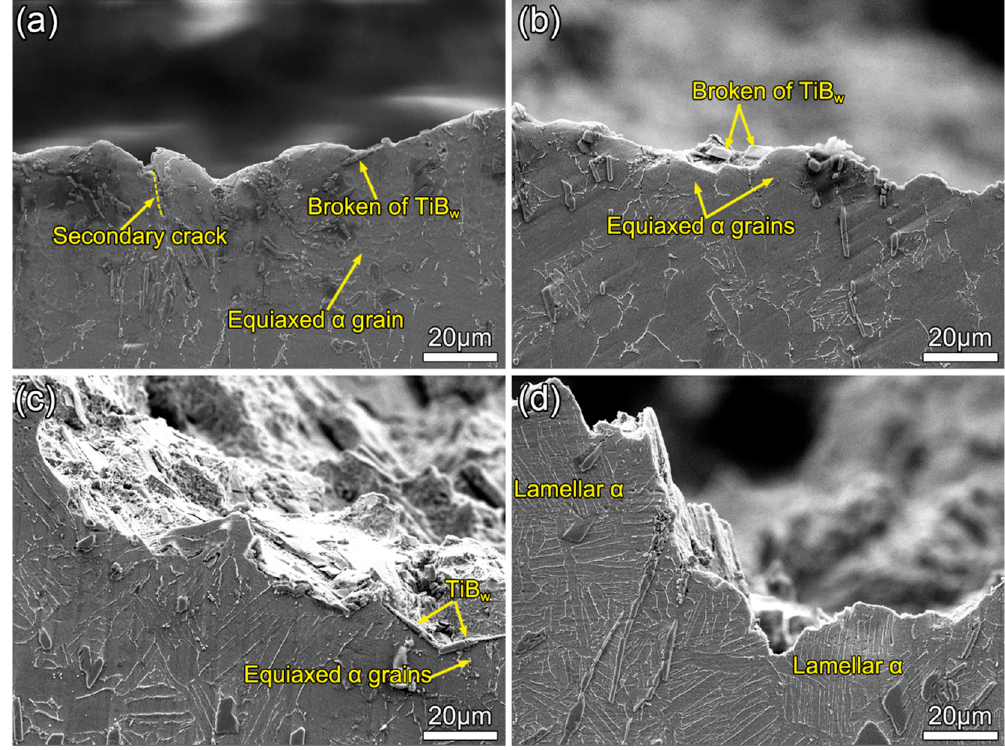
Figure 8. Micrographs of cross-sections of fracture surfaces: ( a ) as-forged; ( b ) HT1; ( c ) HT2; and ( d ) HT3.